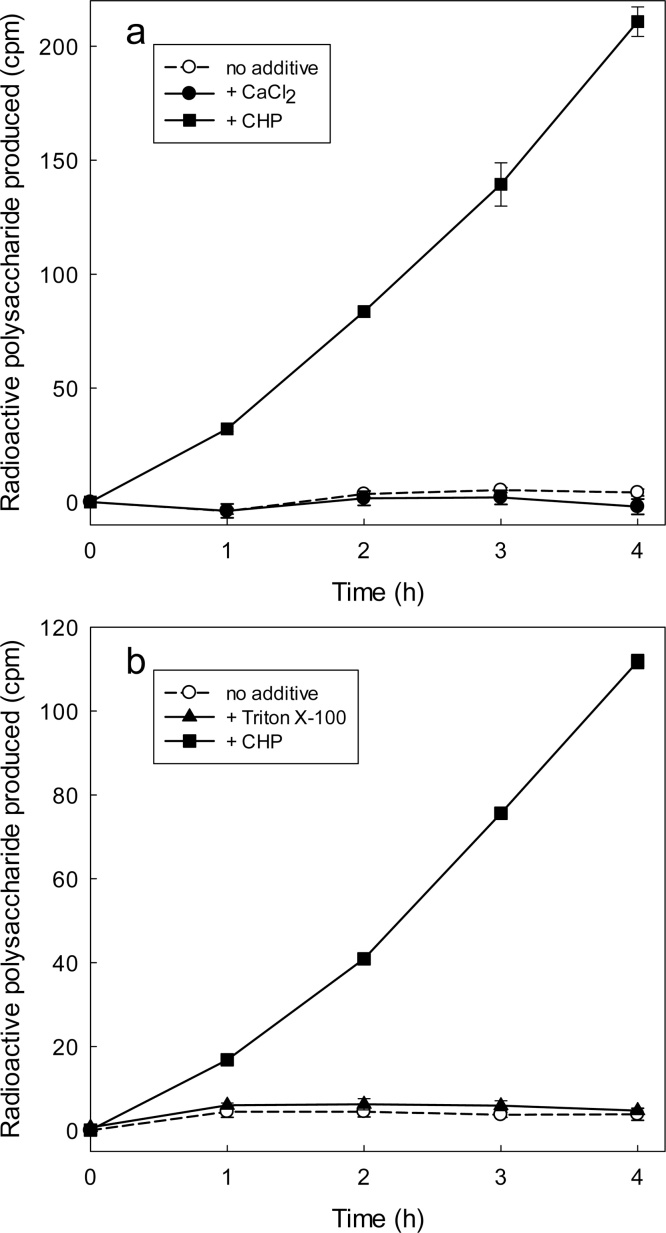
CHP, unlike CaCl2 and a detergent, ‘activates’ previously glass-bound XTH24 in a time-dependent way. (a) Dilute XTH24 (75 μl; protein concentration 2.16 μg/ml) was incubated in borosilicate glass tubes for 2 h to permit binding to the tube surface. The remaining free enzyme solution was then rinsed out with water and 150 μl of an XET reaction-mixture (containing xyloglucan plus [3H]XXXGol), either alone or supplemented with CHP (1.5 mg/ml) or 15 mM CaCl2, was added. At intervals, 20 μl was removed assayed for [3H]polysaccharide. (b) As Fig. a but 0.3% Triton X-100 was tested instead of CaCl2 [cf. critical micelle concentration of Triton X-100 ≈ 0.02%.]. In these experiments, a yield of 100 cpm of 3H-polysaccharide indicates 7.4 pmol XXXGol incorporated.